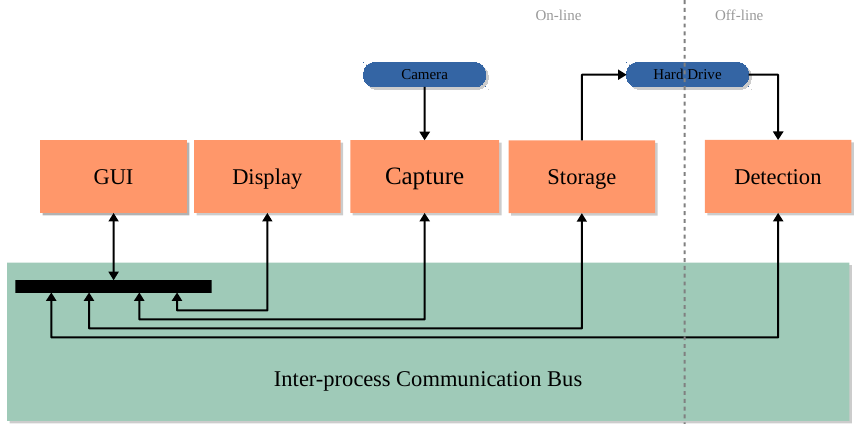
Figure 3. Interoperability and the architecture scheme of the software components to handle the hardware of